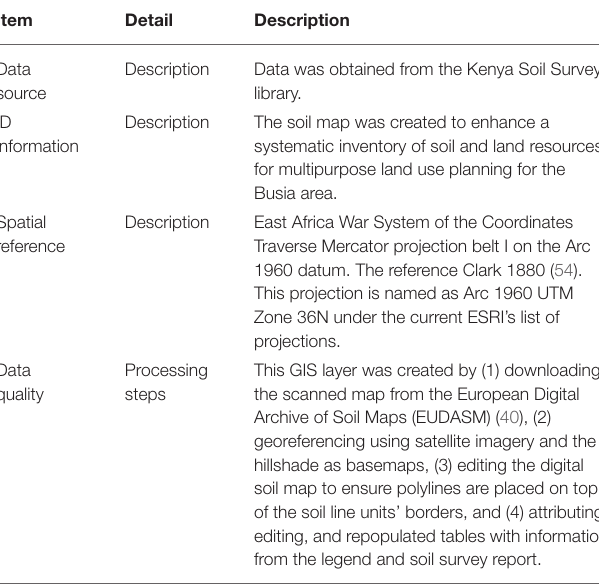
TABLE 5 | Metadata information in the GIS layer of the Reconnaissance Soil Map of the Busia Area